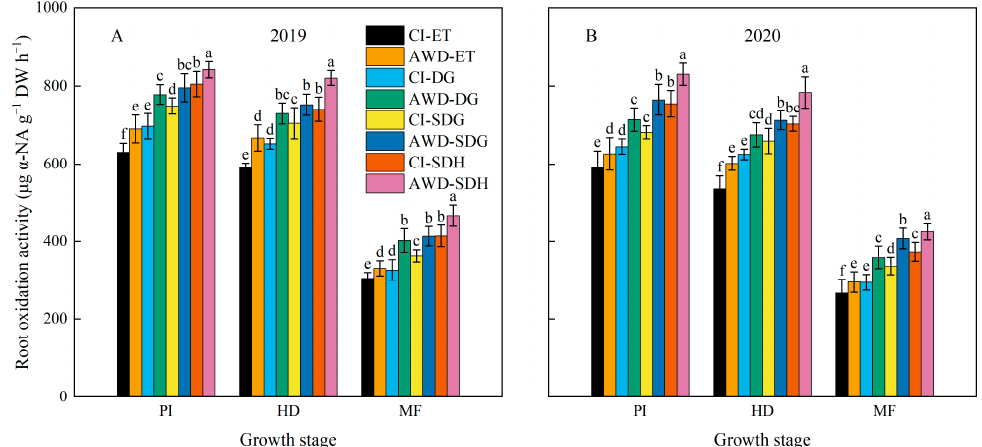
Figure 5. Root oxidation activities ( A , B ) at three growth stages of mid-season indica rice genotypes under different irrigation treatments. CI and AWD represent conventional irrigation treatment and alternate wetting and drying irrigation treatments, respectively. ET denotes early tall genotype, DG denotes dwarf genotype, SDG denotes semi-dwarf genotype, and SDH denotes semi-dwarf hybrid. PI, HD, and MF represent panicle initiation, heading, and middle grain filling stage, respectively. Vertical bars represent ± standard error of the mean where these exceed the size of the symbol. Different letters above the columns indicate significant differences ( p ≤ 0.05) within the same measurement time.